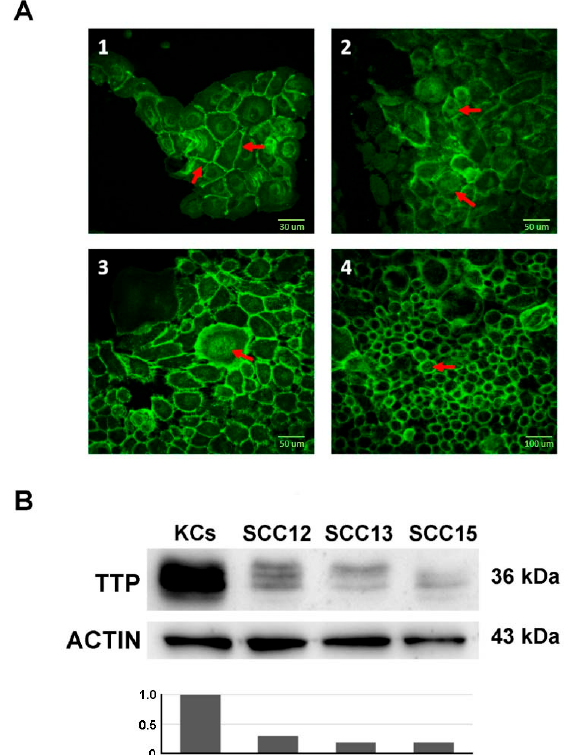
Figure 1. Immunofluorescence highlighting CTNNB1 localization and immunoblotting of ZFP36 expression. Panel ( A ) shows confocal microscope images of healthy keratinocytes (panel ( A ( 1 ))) and SCC12, SCC13 and SCC15 (Panels ( A ( 2 )), ( A ( 3 )) and ( A ( 4 )) respectively). Scale bars 30 µ m, 50 µ m and 100 µ m. Panel ( B ) shows the western blot analysis of TTP expression in the three SCC cell lines compared to normal keratinocytes. The plot below indicates the normalized densitometric analysis of immunoblot.